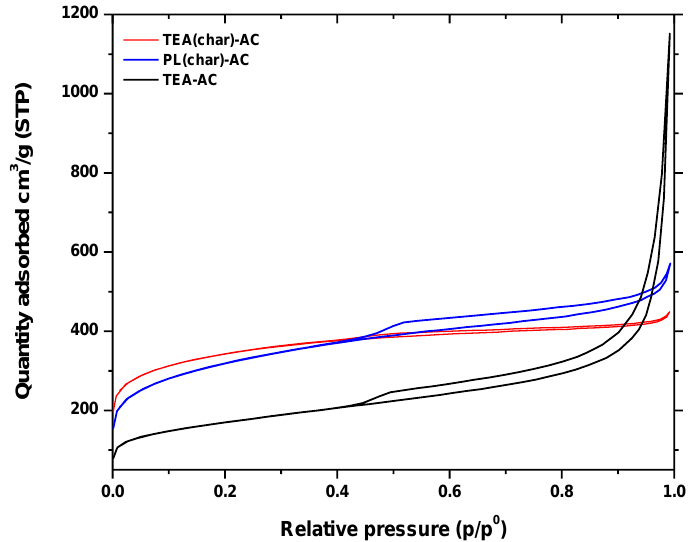
Figure 1. N 2 physisorption isotherms of the synthesized activated carbon (AC) samples.